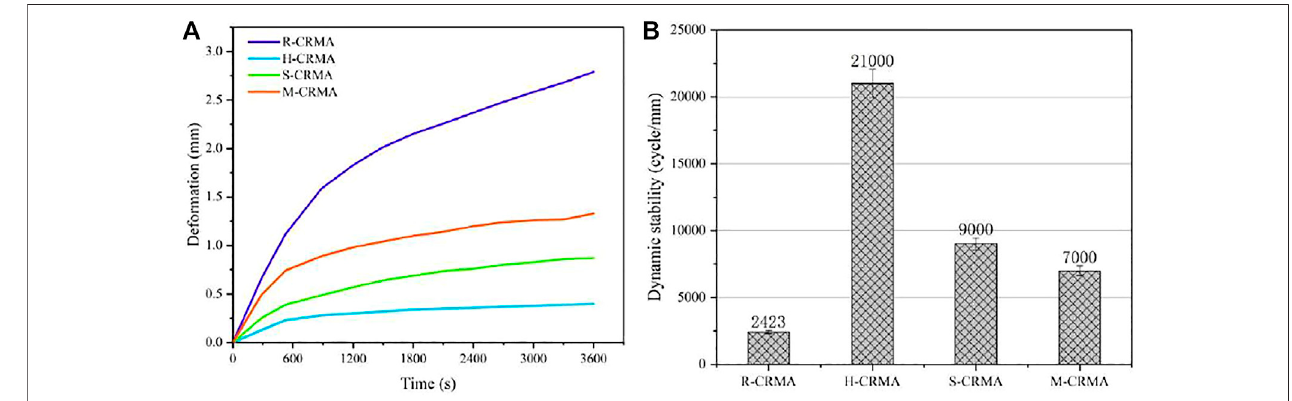
FIGURE 6 | The wheel-tracking test results: (A) the deformation against loading time; (B) the dynamic stability of various asphalt mixtures.